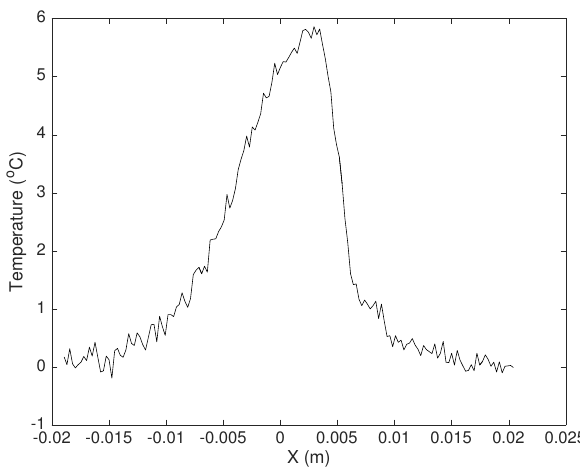
Figure 2. Temperature on the symmetry axis, 20 s after laser